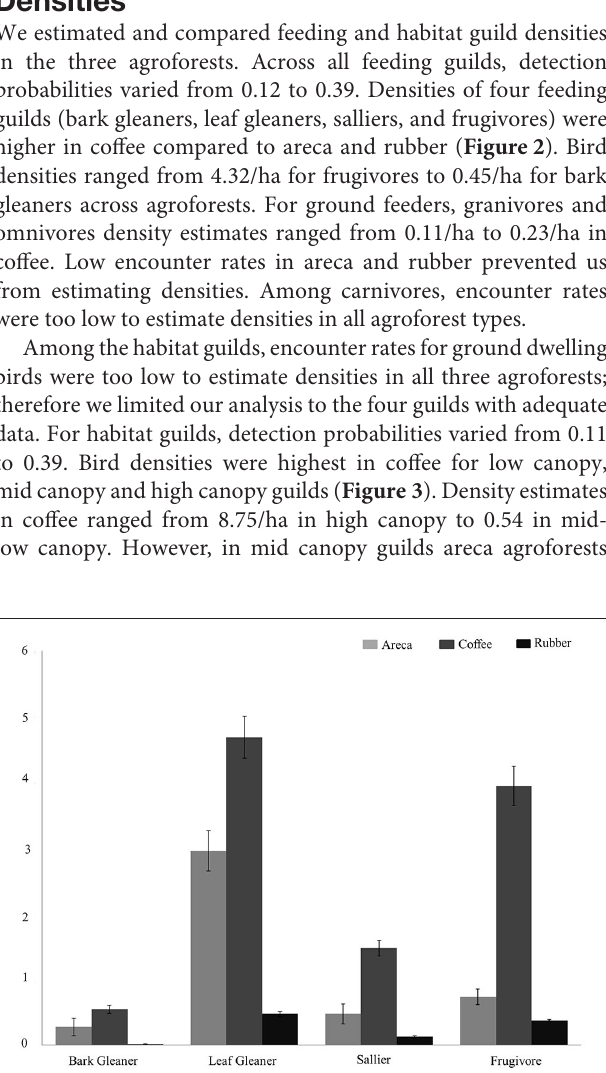
FIGURE 2 | Bird density (per hectare) across the three agroforests for four feeding guilds: Leaf Gleaners, Frugivores, Salliers, Bark Gleaners.